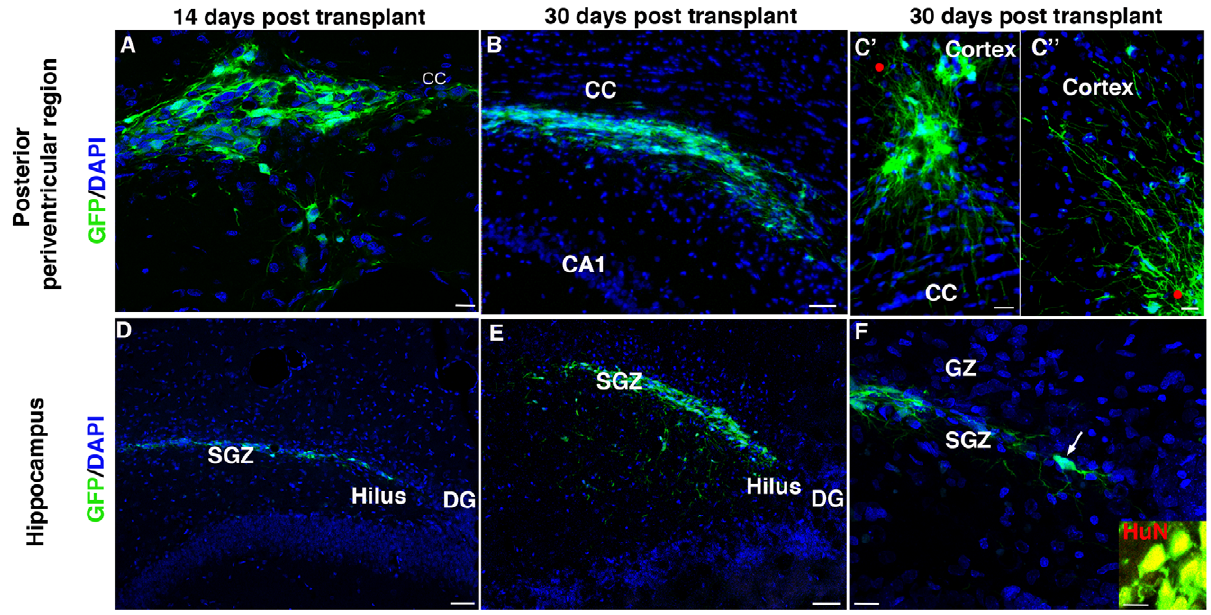
Figure 2. GFP-IhNSC-Ps survive in the ischemic brain. (A–C 0 ) IhNSC-Ps into the cc at 14 (A) and 30 (B) days post transplant. Long processes from donor cells directed toward the cc (C 9 ) and the upper cortical layer (C 0 ). (D–F) Distribution of IhNSC-Ps along the SGZ at 14 days (D) and migrating to the lower SGZ at 30 days (E). Single GFP-IhNSC-Ps with tipical stem cell phenotype in the SGZ (F, arrow). Confocal analysis of colocalization of HuN with GFP (inset in F). cc: corpus callosum, GZ: granular zone, SGZ: subgranular zone, DG: dentate gyrus. Scale bars: A, F, F inset: 10 m m, C 9 and C 0 : 20 m m, B, D, E: 50 m m.